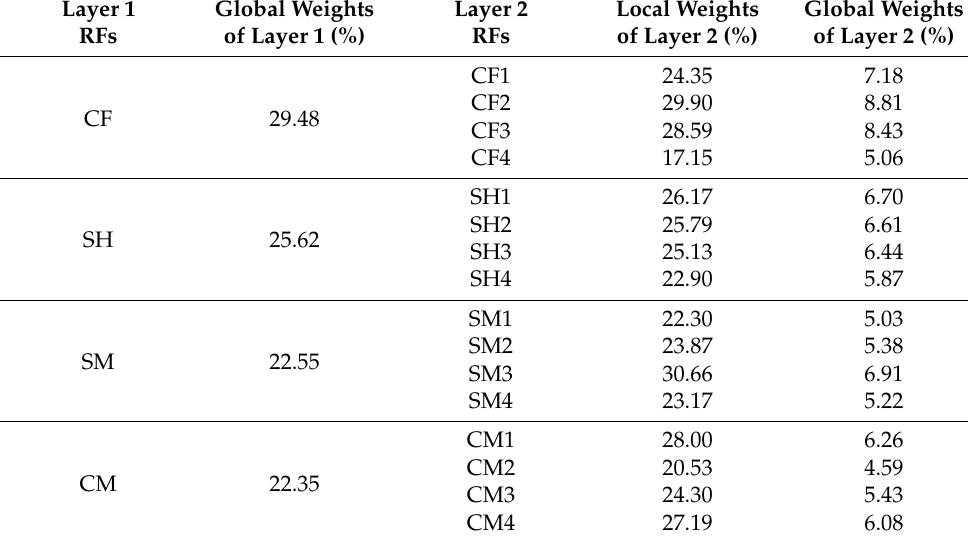
Table 7. The likelihood weights of risk factors